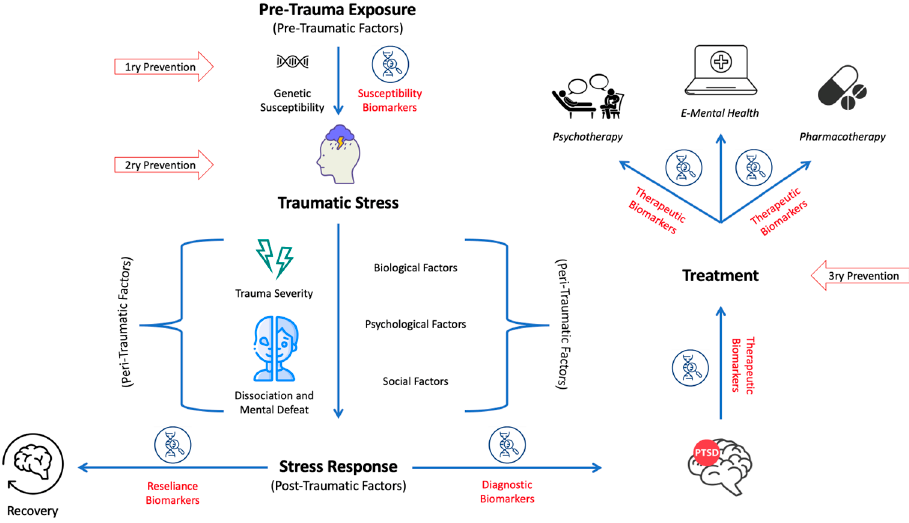
Figure 1. A graphical summary of the main findings of the paper. The entirety of the pre-, peri- and post-traumatic factors can be biological, psychological, or social, according to the biopsychosocial